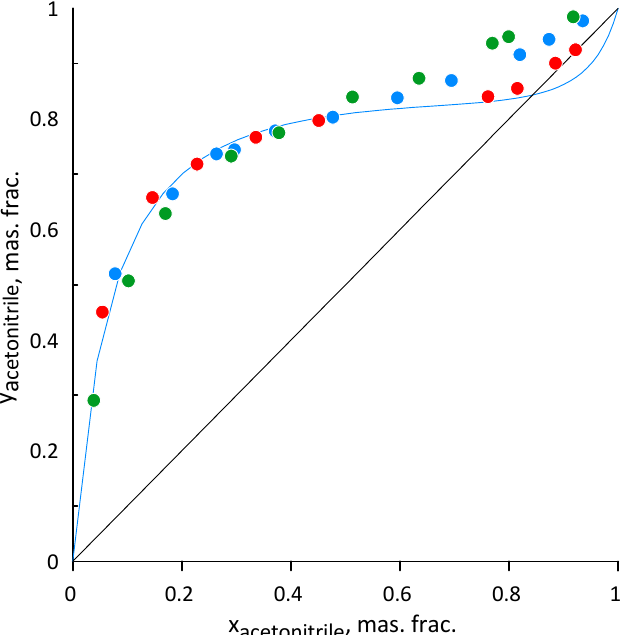
Figure 7. Equilibrium of vapor–liquid in the system acetonitrile-water-AEBA–TEG. The line is a binary mixture, geometric figures with the addition of AEBA–TEG (red circles—20 wt.%, blue circles—40 wt.%, green circles—60 wt.%). Table 1. Experimental TPXY data on vapor–liquid equilibrium for an acetonitrile–water mixture in the presence of AEBA–TEG at various concentrations. T, K x acetonitril y acetonitril